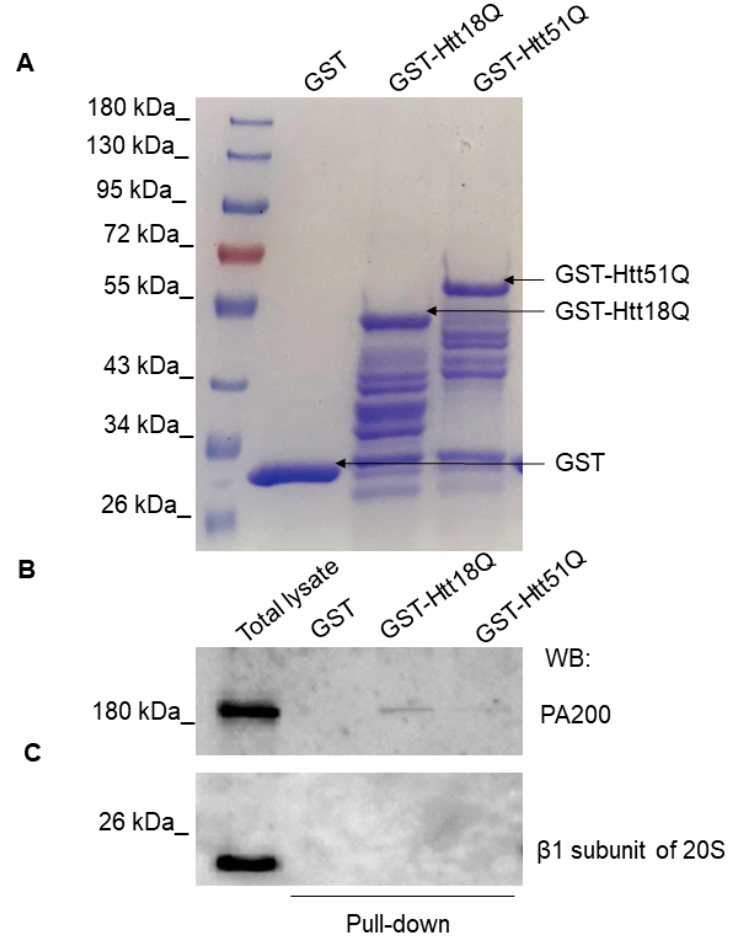
Figure 4. PA200 binds to wt and mutant N-Htt in vitro. ( A ) Bacterially expressed glutathione S-transferase (GST), GST-Htt18Q, and GST-Htt51Q were loaded onto glutathione sepharose and purified. The e ffi ciency of protein purification was visualized by Coomassie Blue staining. ( B , C ) GST, GST-Htt18Q, and GSTHtt51Q recombinant proteins were immobilized on GSH–Sepharose 4B and incubated with SH-SY5Y neuroblastoma cell lysate. Eluted proteins were analyzed with antibodies specific for PA200 ( B ) and β 1 subunit of 20S CP ( C ) by Western